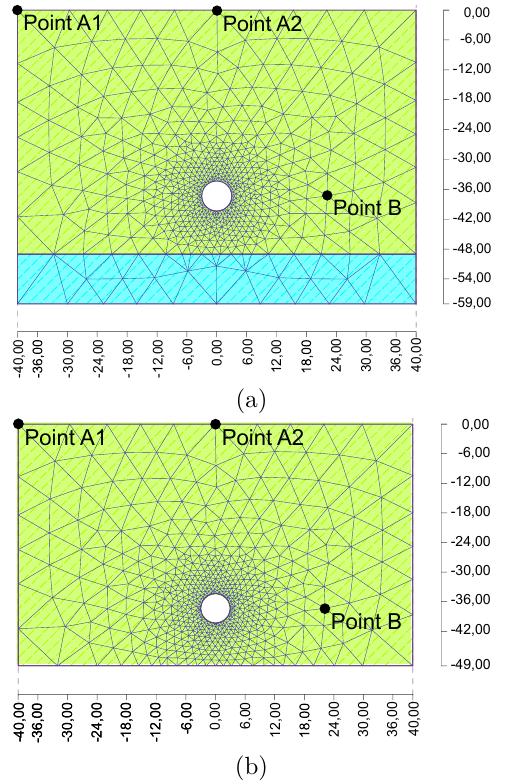
Figure 4. Computational model - a) quiet bound- ary conditions ( QBB ), b) fixed boundary conditions ( FBB ).